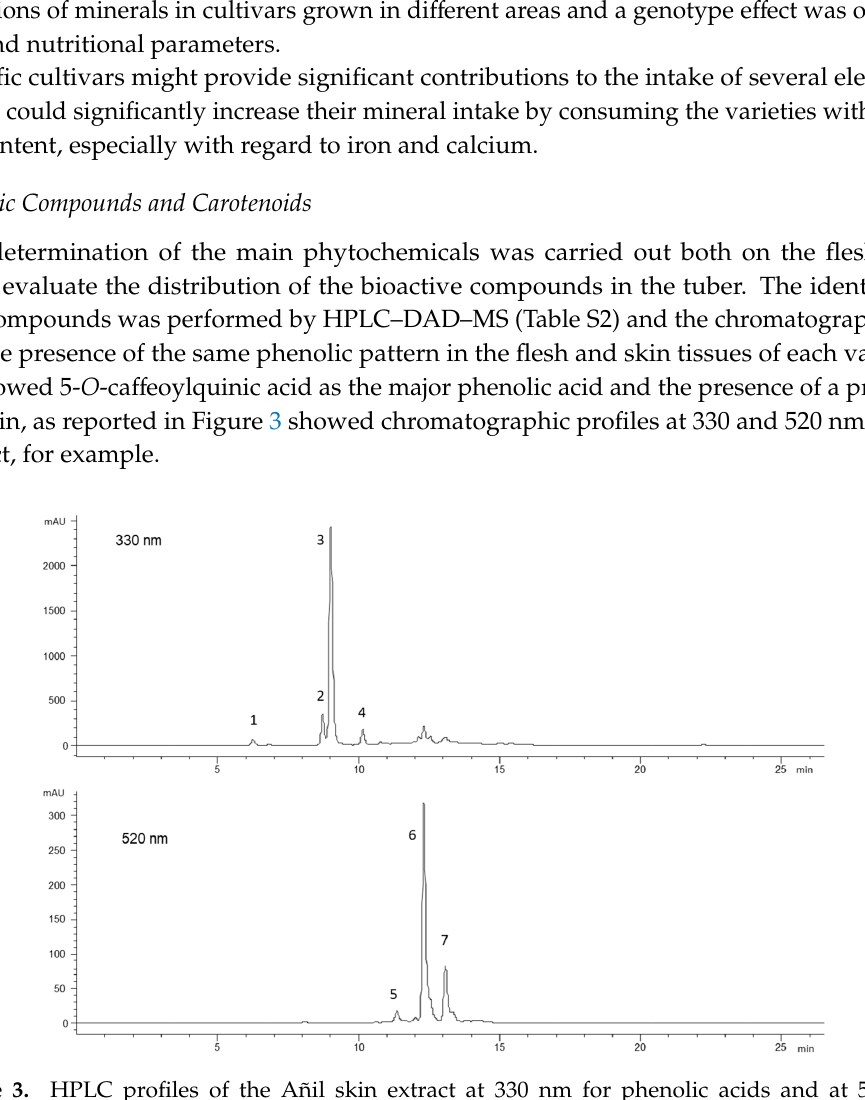
Figure 3. HPLC profiles of the Añil skin extract at 330 nm for phenolic acids and at 520 nm for anthocyanins. (1) 3- O -caffeoylquinic acid, (2) cinnamic acid derivative, (3) 5- O -caffeoylquinic acid, (4) 4- O -caffeoylquinic acid, (5) petunidin 3- O -caffeoyl-rutinoside-5- O -glucoside, (6) petunidin 3- O -coumaroyl-rutinoside-5- O -glucoside, and (7) peonidin 3- O -coumaroyl-rutinoside-5- O -glucoside.